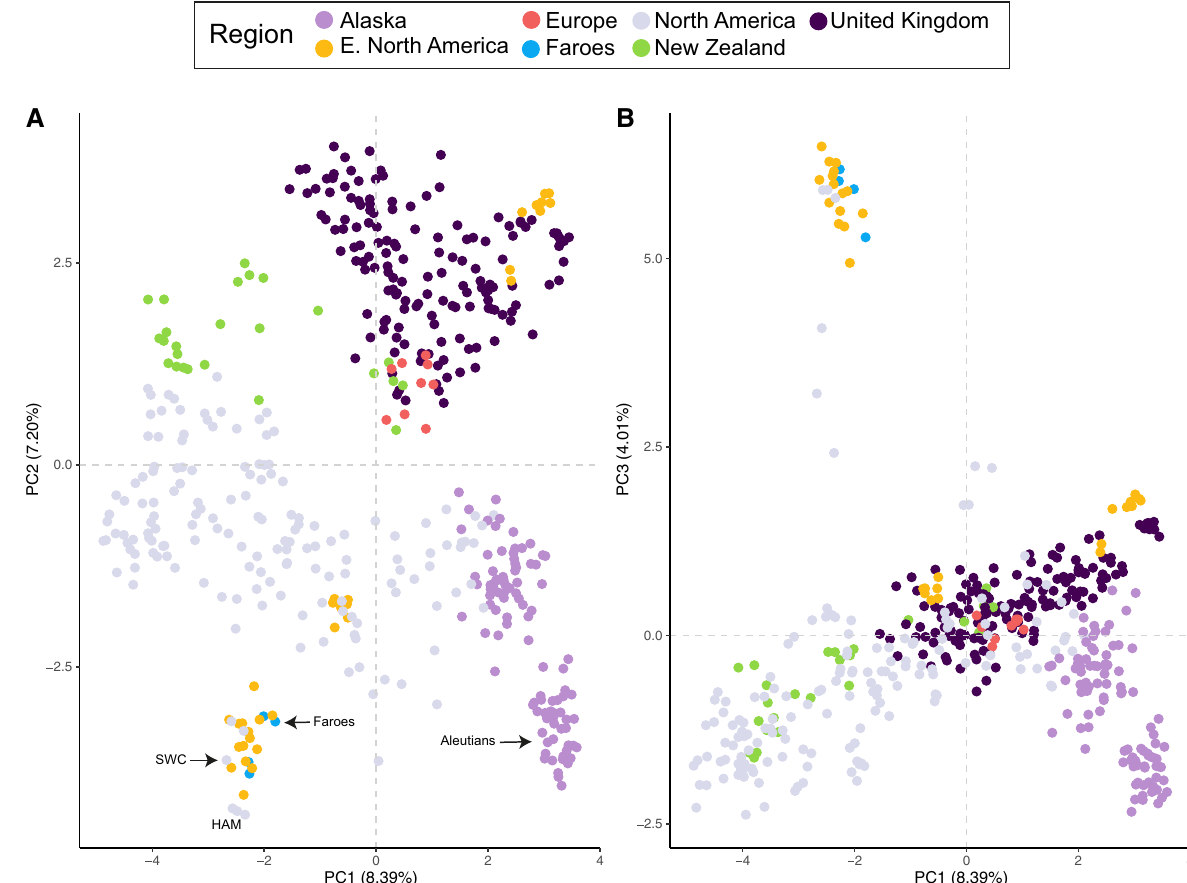
Fig. 3 Principal component analyses of native and introduced Mimulus guttatus . Principal component analysis (PCA) of 474 individuals of Mimulus guttatus from both native and introduced populations genotyped at 1498 binary SNP loci. A Scatterplot of the fi rst two principal components (PC2 vs. PC1). B Scatterplot of fi rst and third principal components (PC3 vs. PC1). Colours indicate sample regions. An interactive 3D fi gure with individually labelled data points is available at: https://mvallejo6.github.io/mimulus_voyage/. A visualisation of the fi rst 200 principal components (cumulative variance explained = 90.9%) projected in two dimensions using Uniform Manifold Approximation and Projection for Dimension Reduction (UMAP) 77 is shown in Supplementary Fig.